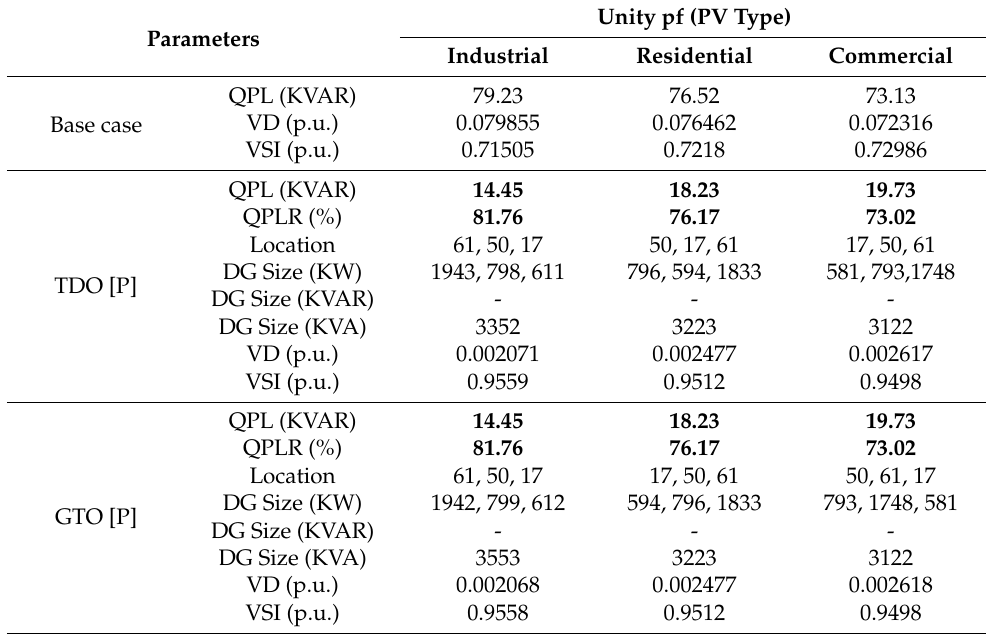
Table A7. Results of OADG for a 69-bus RDN for QPL minimization at unity pf (PV type) in a VP load model.